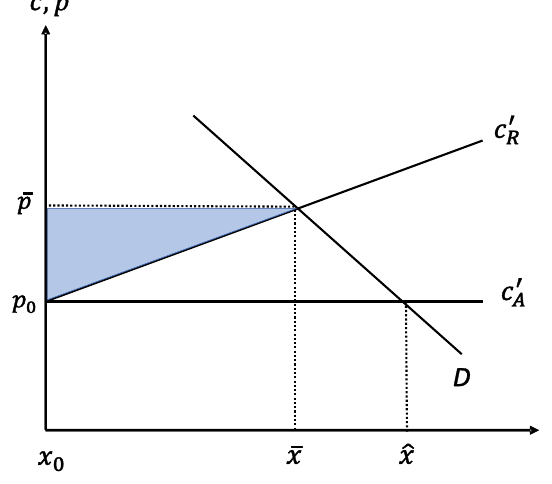
Figure 2. Ricardian resource